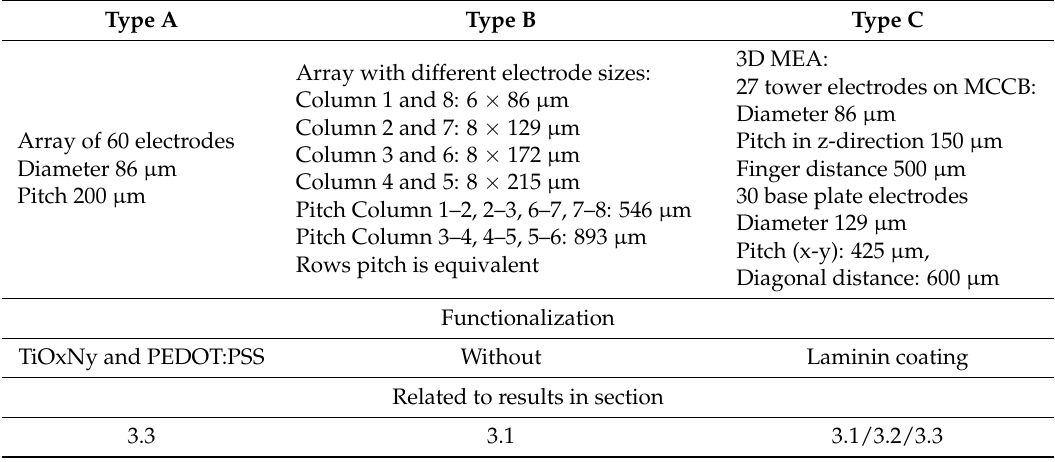
Table 1. Design and electrode geometry of different MEA